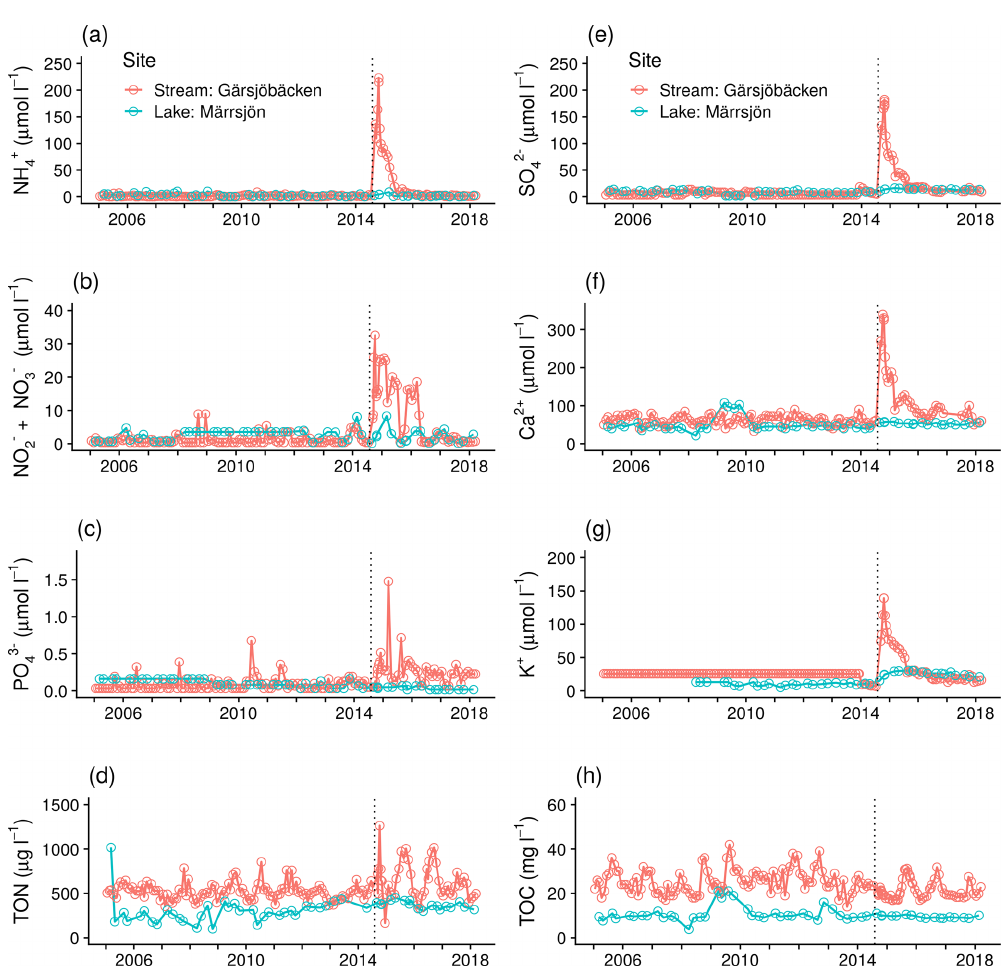
our calculated total C loss). This maximum value is likely